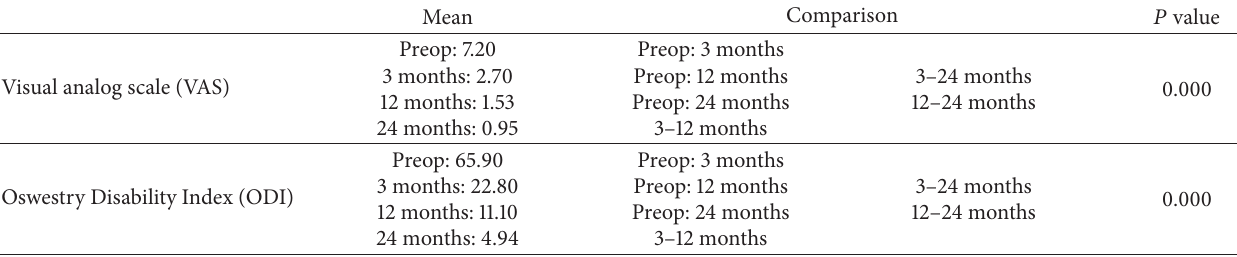
Table 2: Comparison of the outcomes of visual analog scale (VAS) and Oswestry Disability Index (ODI) scores in the groups. Both groups exhibited significant reduction in pain over